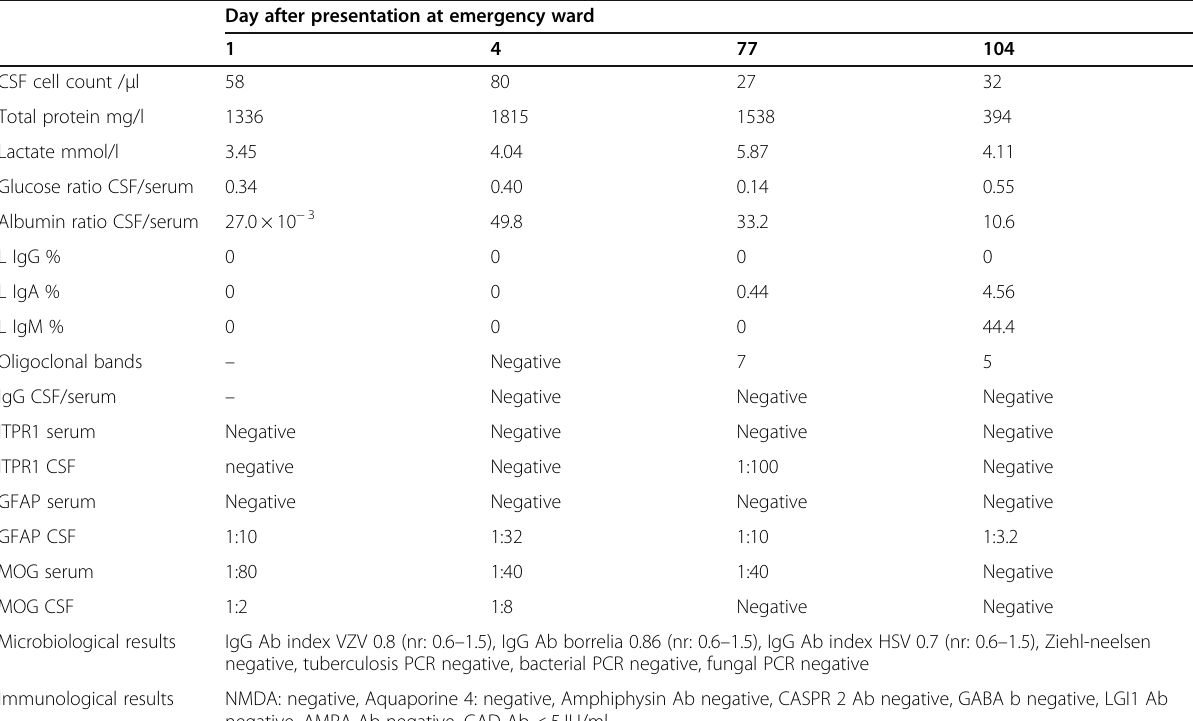
Table 1 Selected cerebrospinal fluid findings Day after presentation at emergency